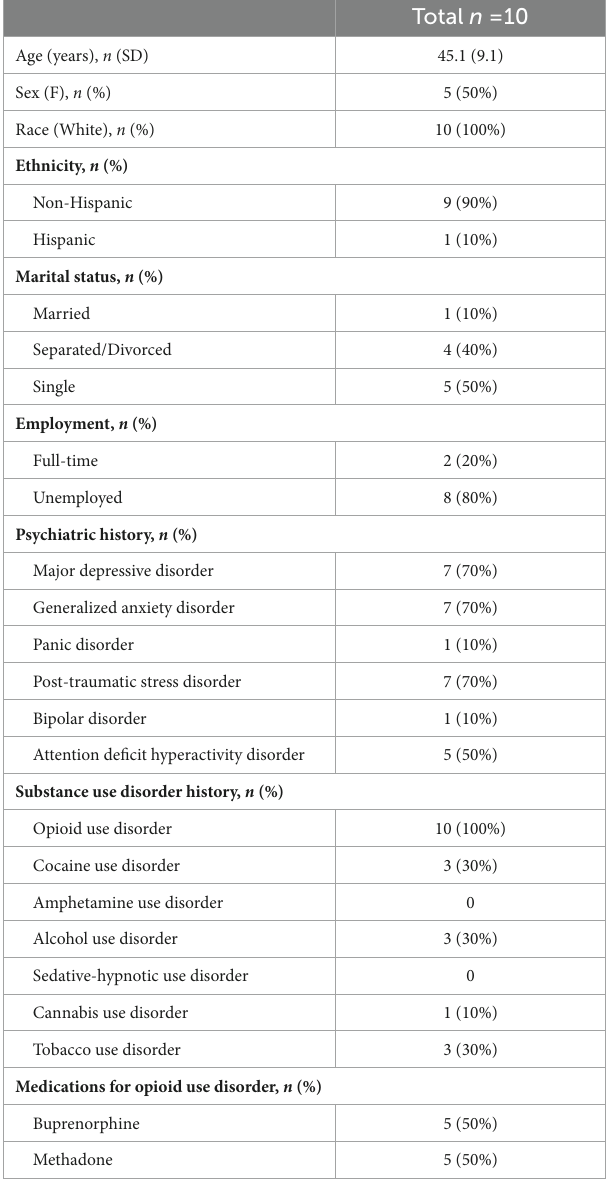
TABLE 1 Summary of participant